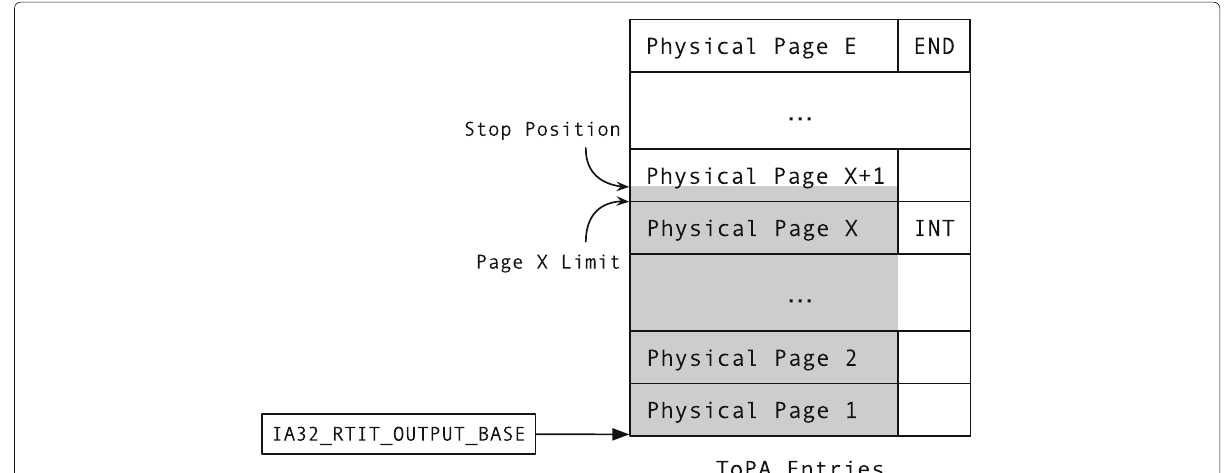
Intel PT is enabled, a Packet Generation Enable (PGE) packet leads the following packets. After executing a con- ditional branch, the Taken or Not Taken (TNT) decision is recorded in a TNT packet. On an indirect jump, a Target IP (TIP) packet records the destination address. A Packet Generation Disable (PGE) packet marks the end of the packet flow once the tracing facility is turned off. Intel has proposed a new instruction PTWRITE on future generation Intel processors. It makes Intel PT generate a packet whose payload is PTWRITE ’s parame- ter. Intel suggests to use it to provide more information about the program execution for debuggers (Strong et